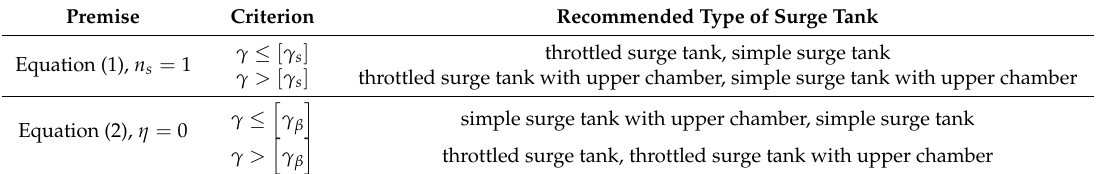
Table 3. Applicable conditions of three types of surge tanks